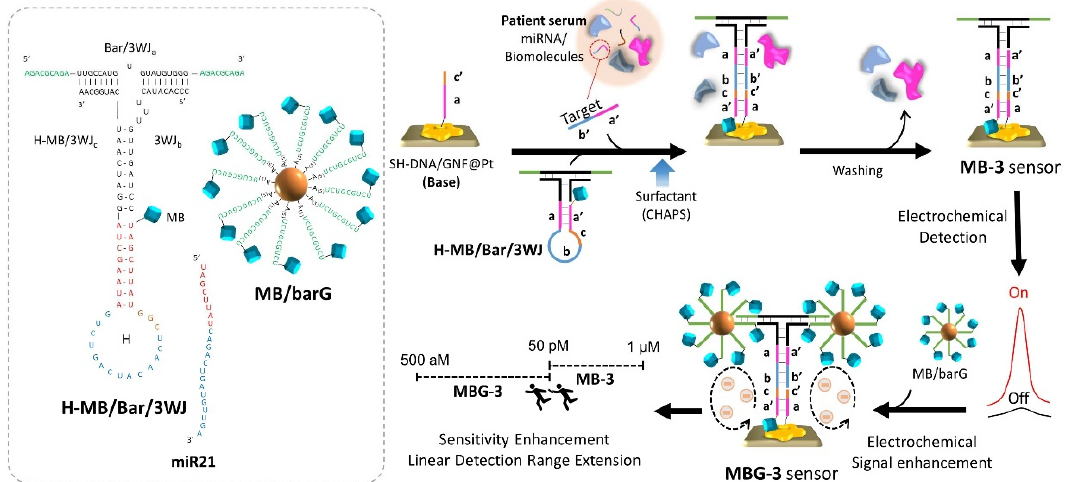
Figure 5. Schematic diagram of the relay-race electrochemical biosensor. Left panel: the predicted structures and nucleic acid sequences of the H-MB/Bar/3WJ, miR21 and MB/barG [73], reprinted with permission from